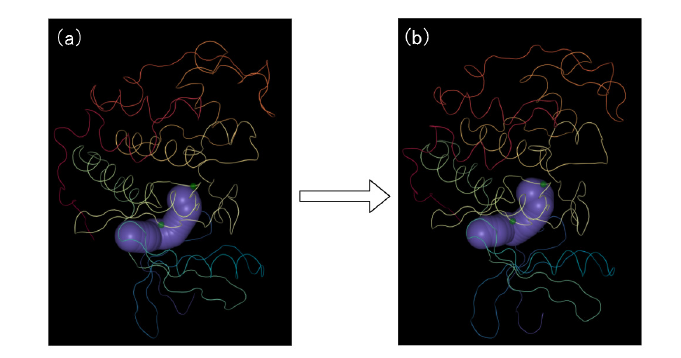
Figure 9. The PCD 3D View shows the protein structure, cavities, and amino acids dynamically changing over time. ( a ) represents the initial conformation of the molecular motion; ( b ) represents the end conformation of the molecular motion. The cavity is shown in purple. The protein molecule cartoon is shown in multiple